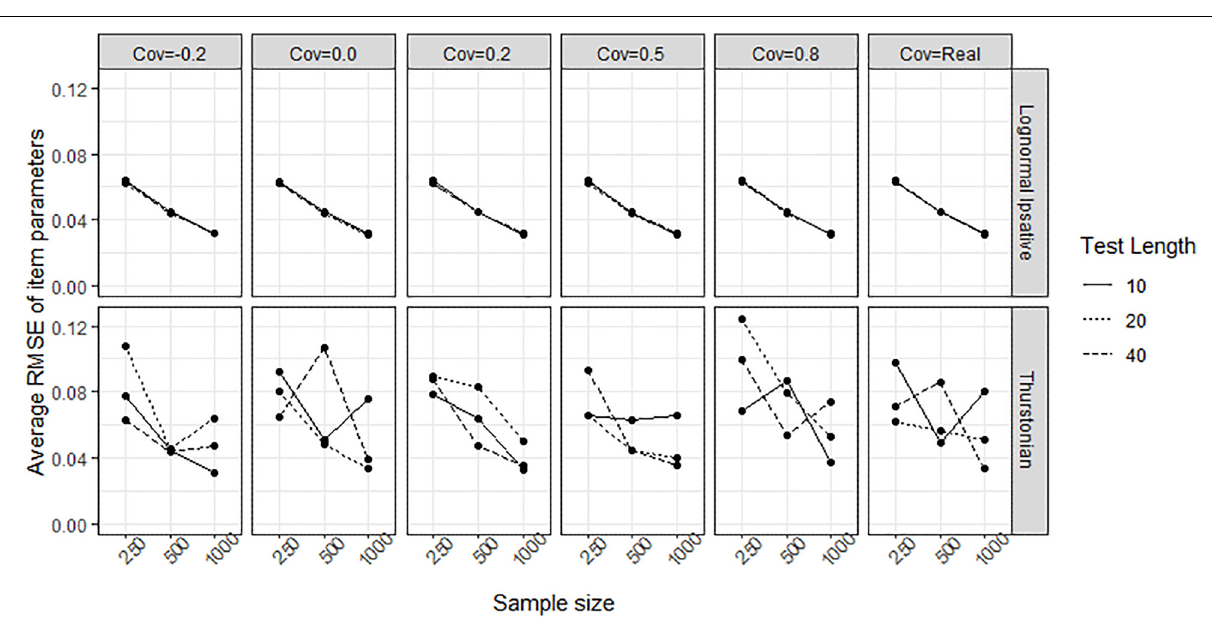
FIGURE 9 | Average RMSE of item parameters obtained by fitting the lognormal ipsative model and the Thurstonian model to simulated data. RMSE is root mean square errors. The types of lines indicate the test lengths. Cov = the covariance between latent trait. Cov = Real indicates the variance-covariance matrix followed the empirical result in